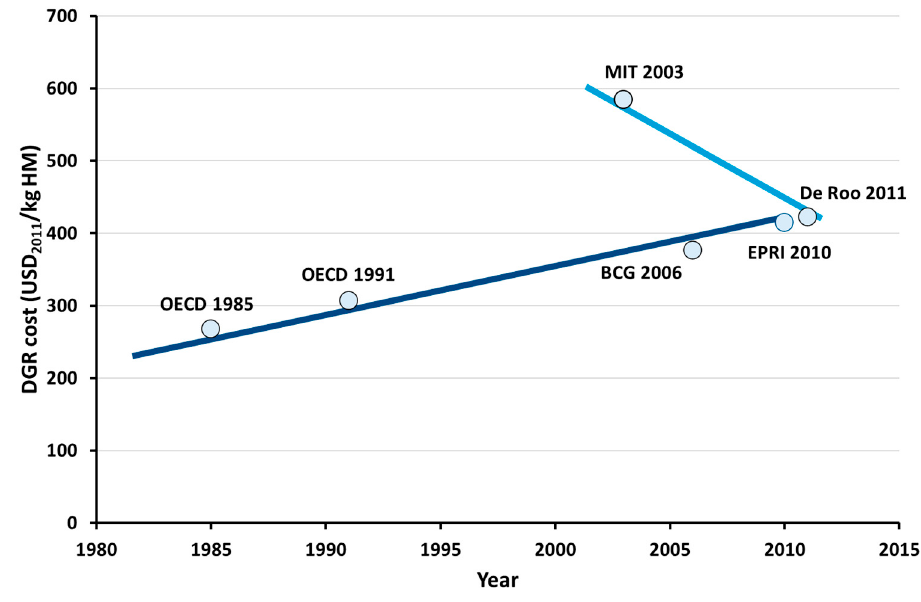
Figure 6. Cost trends for the DGR in the TTC based on analysis in [62].